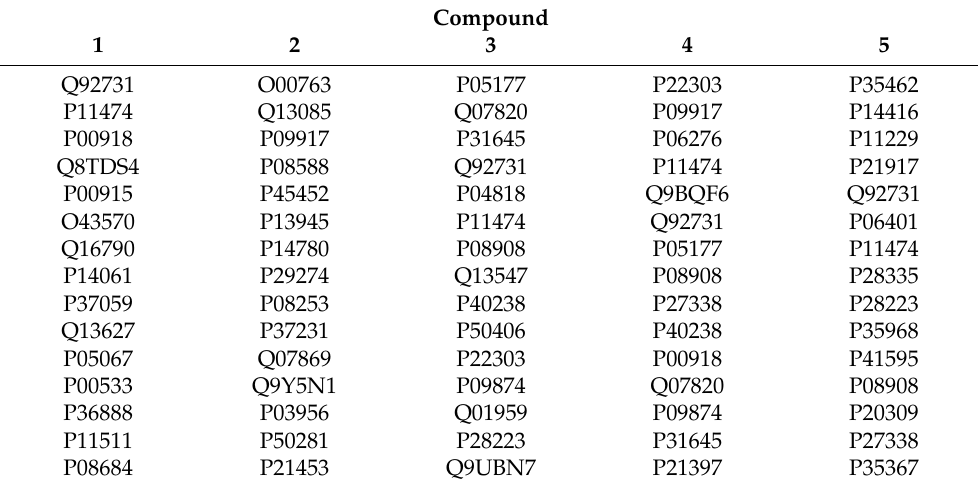
Table 1. Best 15 predicted targets, represented as UniProtKB entries (see Table S1 for protein names), for each evaluated compound using Polypharmacology browser 2 servers.